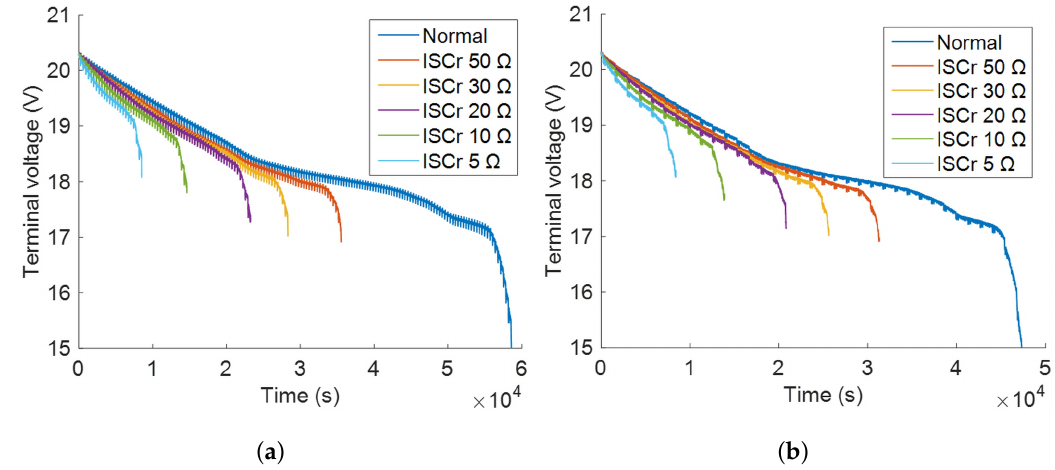
Figure 5. Terminal voltages of battery packs with different R ISCr s in experiment with ( a ) dynamic stress test (DST) current profile, and ( b ) urban dynamometer driving schedules (UDDS) current